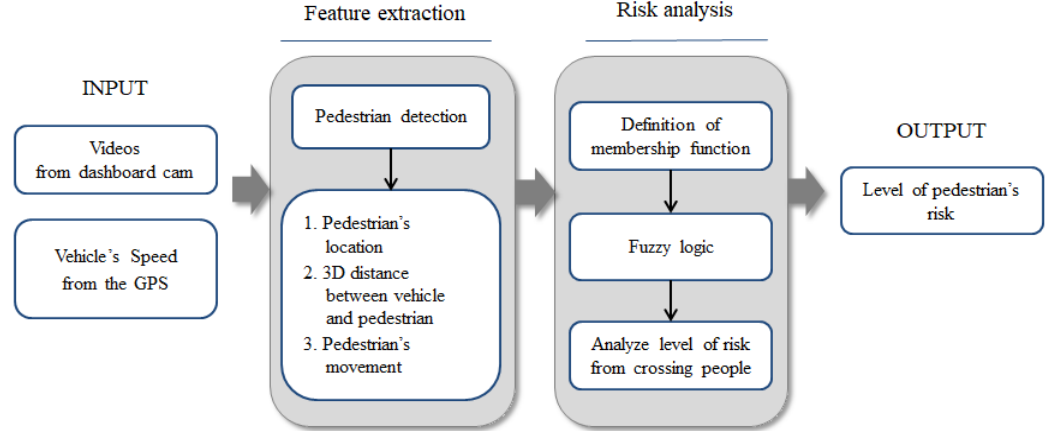
Figure 1. Overview of the proposed system: The system has two main modules, a feature extraction module and a risk analysis module. These take videos from a car dash camera and vehicle speed information from an external GPS module, and output the level of risk to pedestrians.